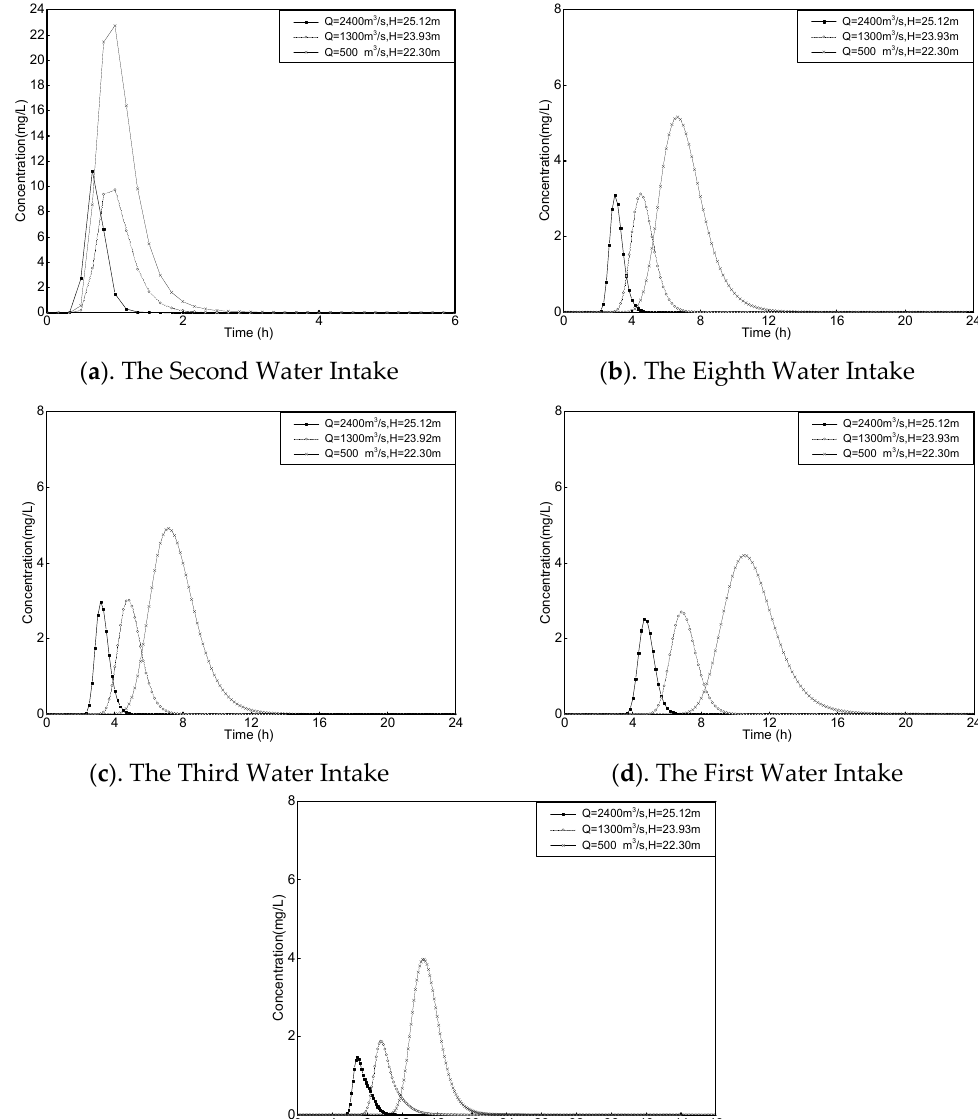
Figure 8. Pollutant concentrations with different discharges at different waterwork intakes along the Xiangjiang River under natural water conditions.